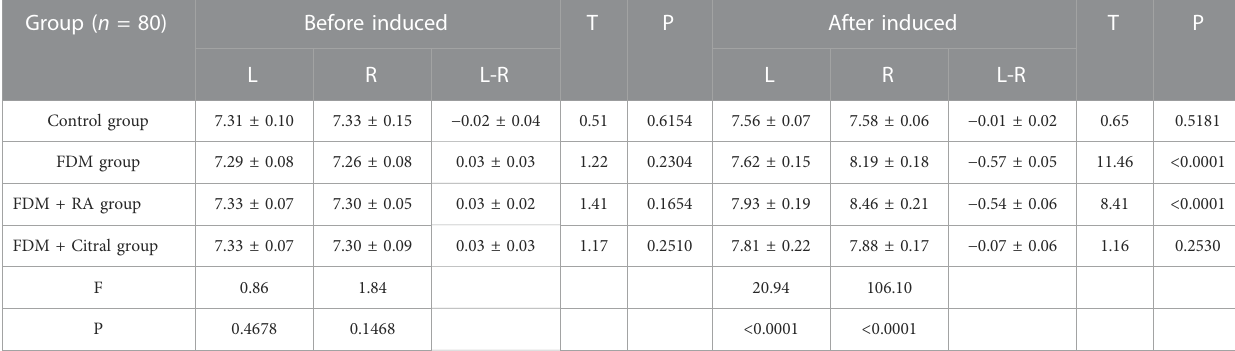
TABLE 2 AL of left and right eyes of guinea pigs before and after experimental induction (mm). Group ( n =